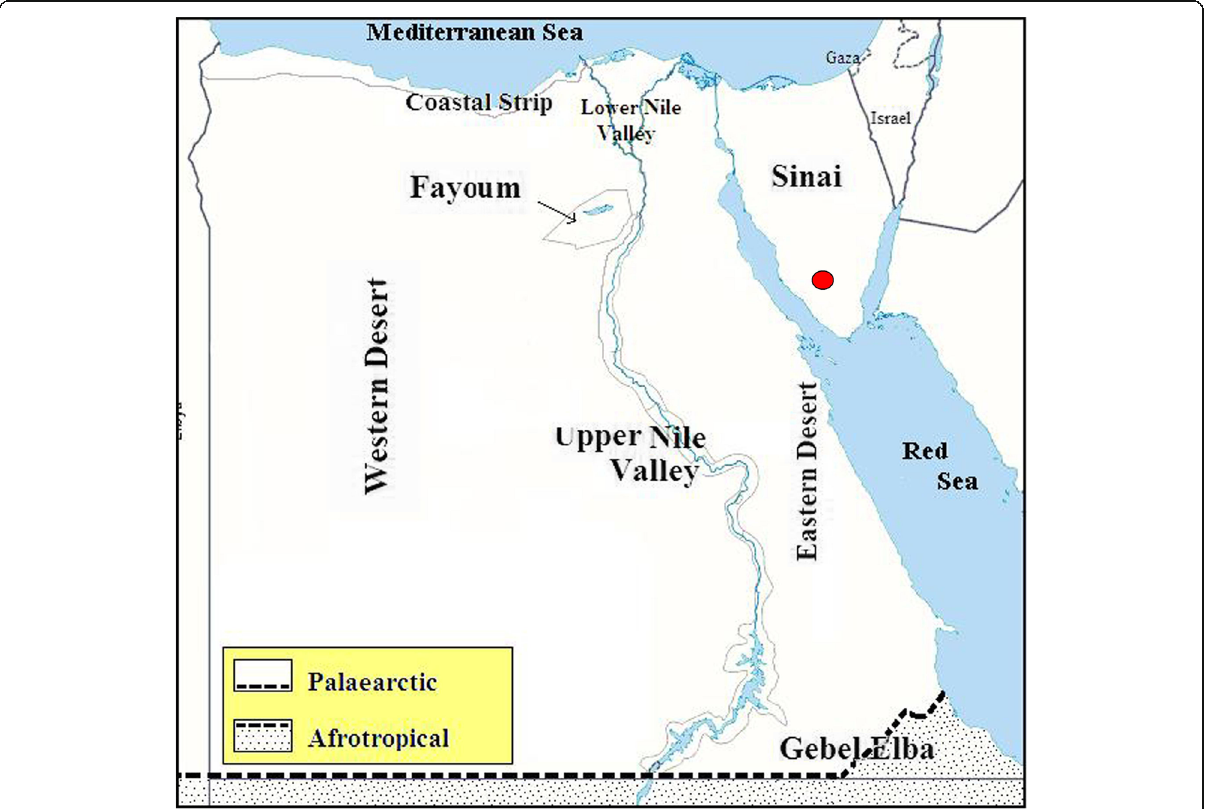
Fig. 1 Map of Egypt showing the collecting locality (modified from El-Hawagry and Gilbert